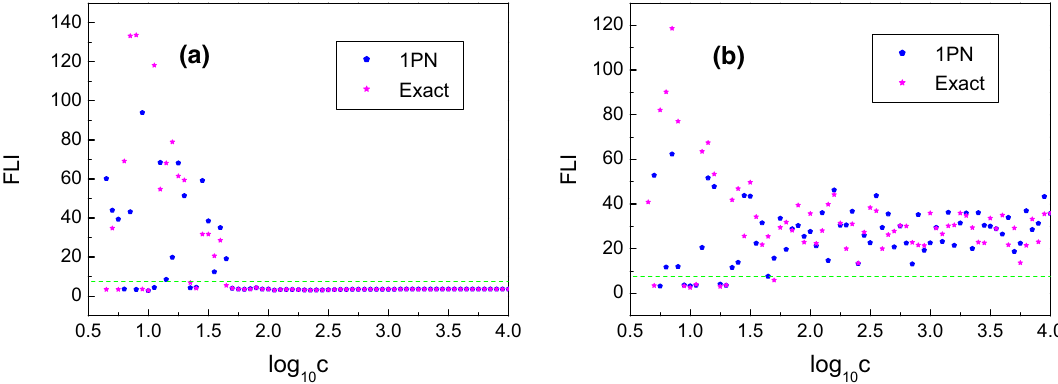
Fig. 8 Dependence of FLIs of Orbit 1 and Orbit 3 on c respectively in the exact system (12) and the 1PN truncated system (16)–(17)